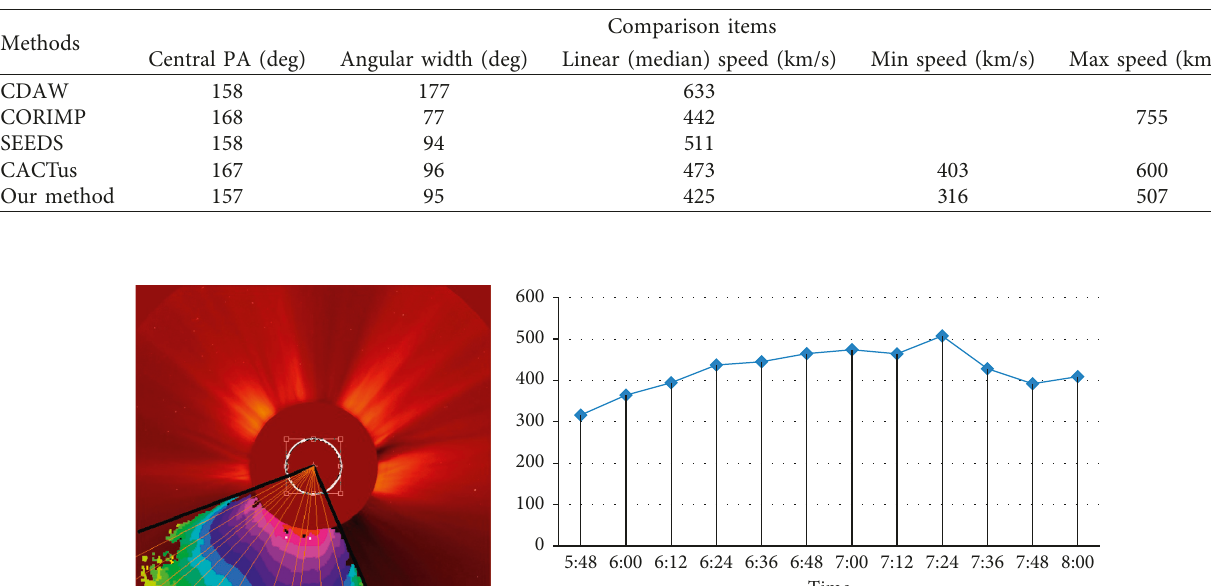
Table 2: CME information comparison table on the event shown in Figure 7.